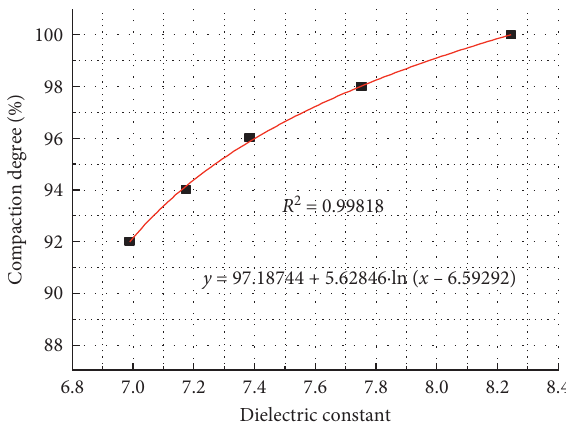
Figure 5: Relationship between the compaction degree and the dielectric constant of coarse specimens.